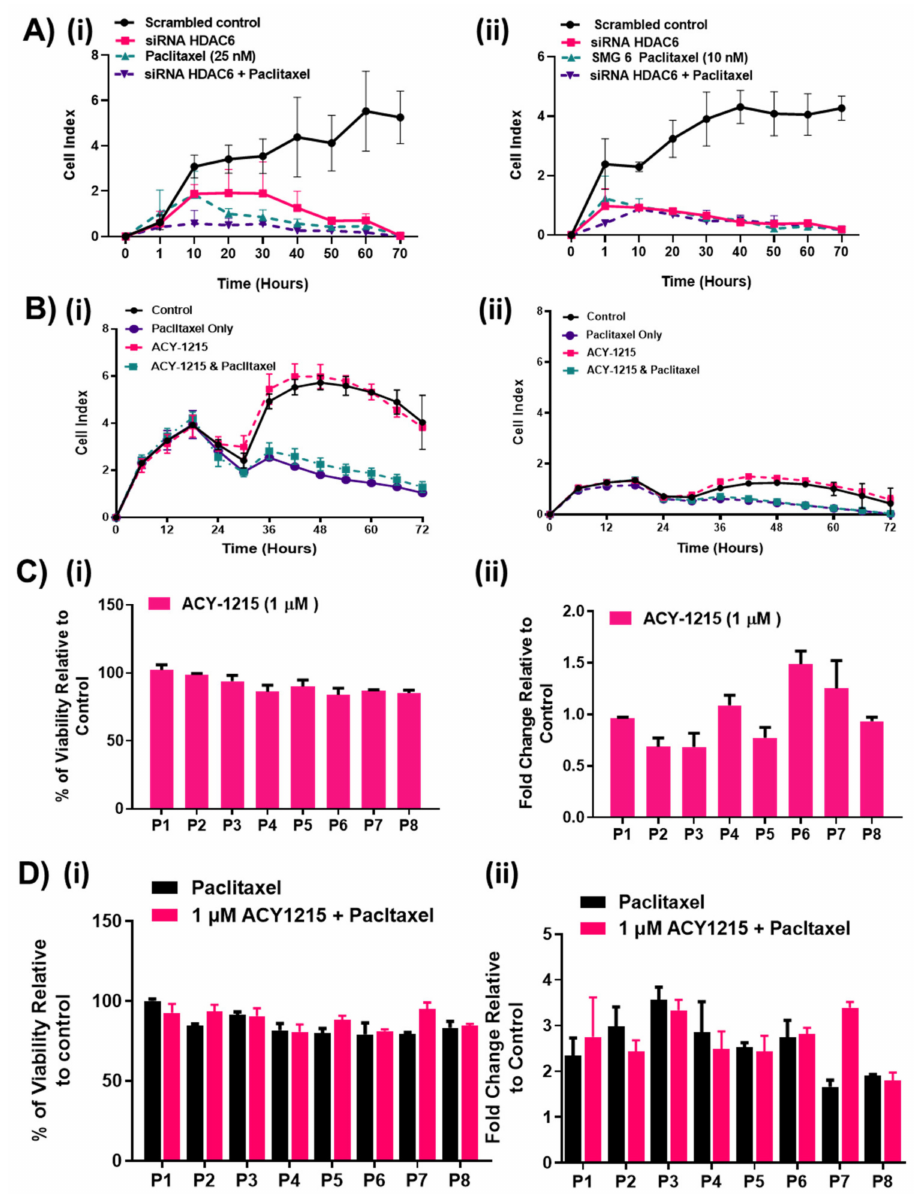
Figure 6. HDAC6 inhibition e ff ect on paclitaxel responses. ( A ) SMG 5 ( i ) and SMG 6 ( ii ) cells were transfected with HDAC6 siRNA followed by treatment with IC50 doses of paclitaxel for further 72 h ( n = 2). ( B ) SMG 5 ( i ) and SMG 6 ( ii ) cells were pre-treated with 1 µ M ACY-1215 and then treated with 1 µ M ACY-1215 in combination with paclitaxel for a further 72 h. Real-time detection of cellular impendence was measured to calculate normalized cell index utilizing the xCELLigence System. Experiments were analyzed by a two-way ANOVA. Error bars represent SEM. ( C , D ) Primary cell cultures from eight HGSOC patients were pretreated with 1 µ M ACY-1215 or a combination of 1 µ M ACY-1215 and paclitaxel for 48 h. ( C ) / ( i) ,( ii ) Viability was measured using the Promega CellTiter-Fluor